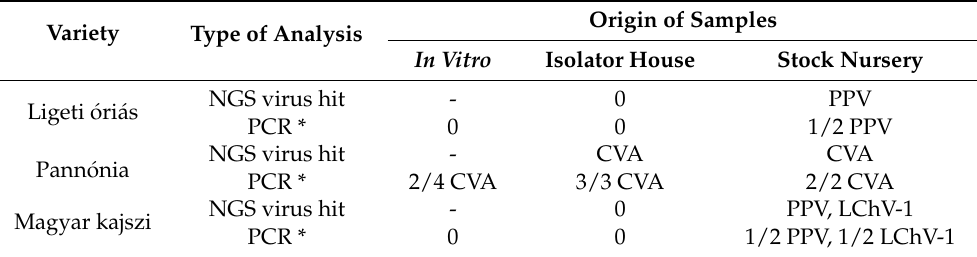
Table 1. Summary of the small RNA NGS virus diagnostics and its RT-PCR validation.